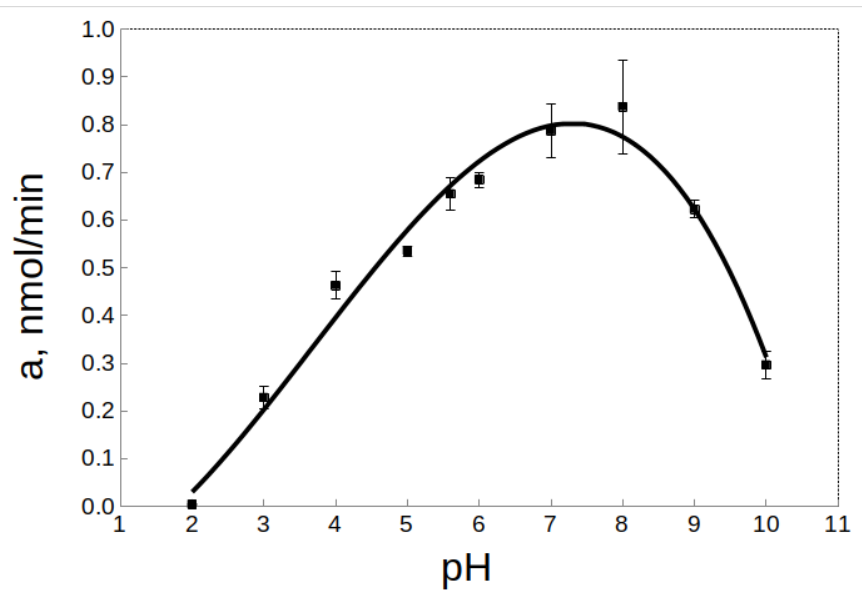
Figure 5. Effect of pH on the activity of rTcCathL1 with the substrate Glp-Phe-Gln-pNA in 0.1 M UB, pH 5.6 in the presence of 6 mM cysteine and 1 mM EDTA.